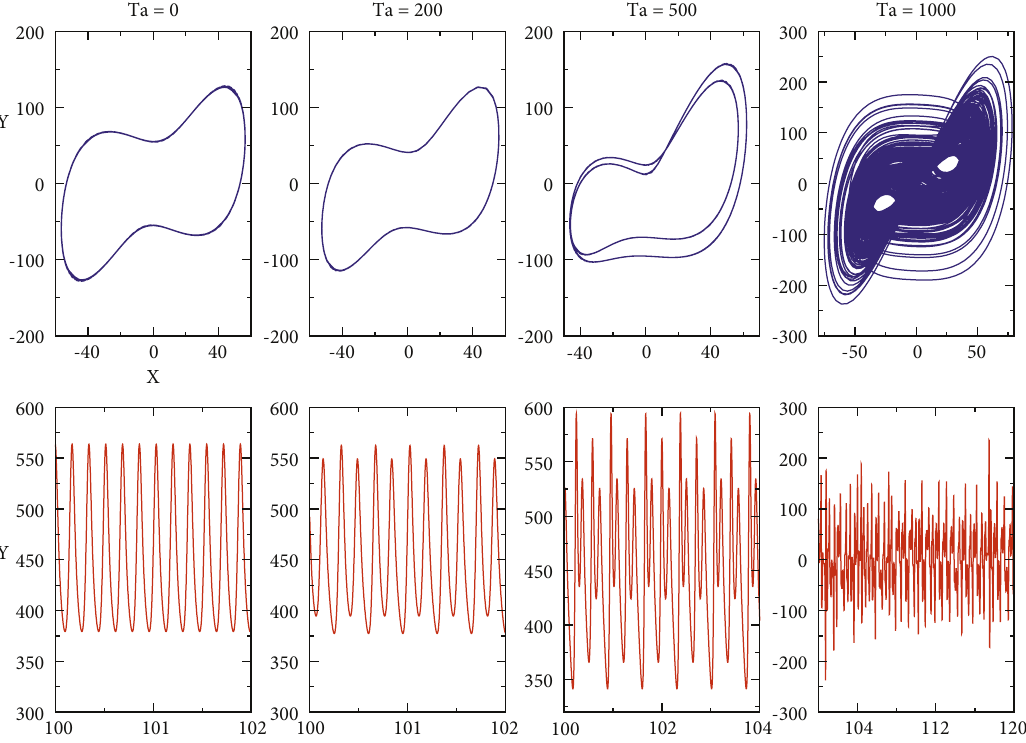
Figure 12: Phase portraits and time stories for a fixed reduced Rayleigh number r � 464 and various values of Ta for Λ � 1 ,s � 0, Da �